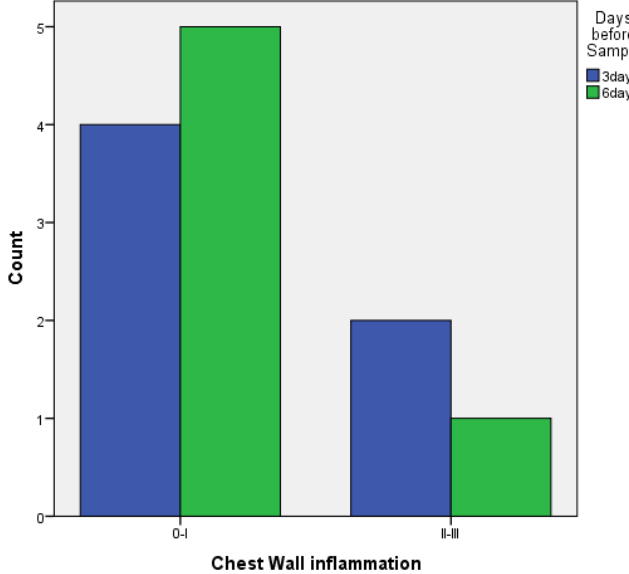
Figure 10. Parietal pleura inflammation 3 vs. 6 days of PRP.